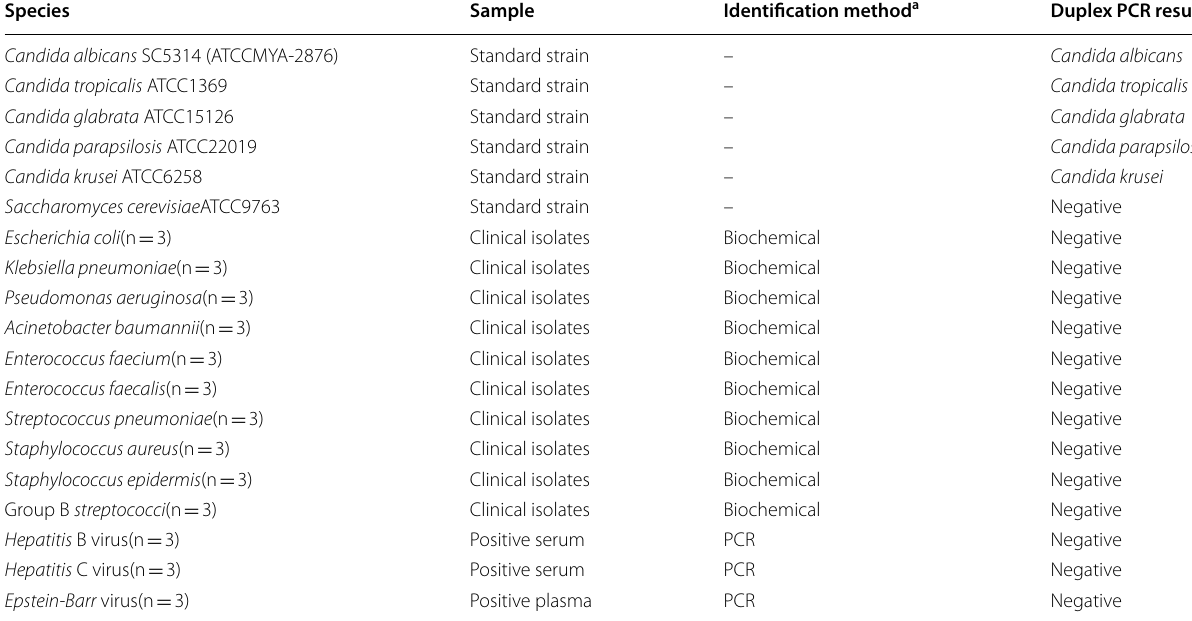
Table 4 Species tested by the duplex PCR assay